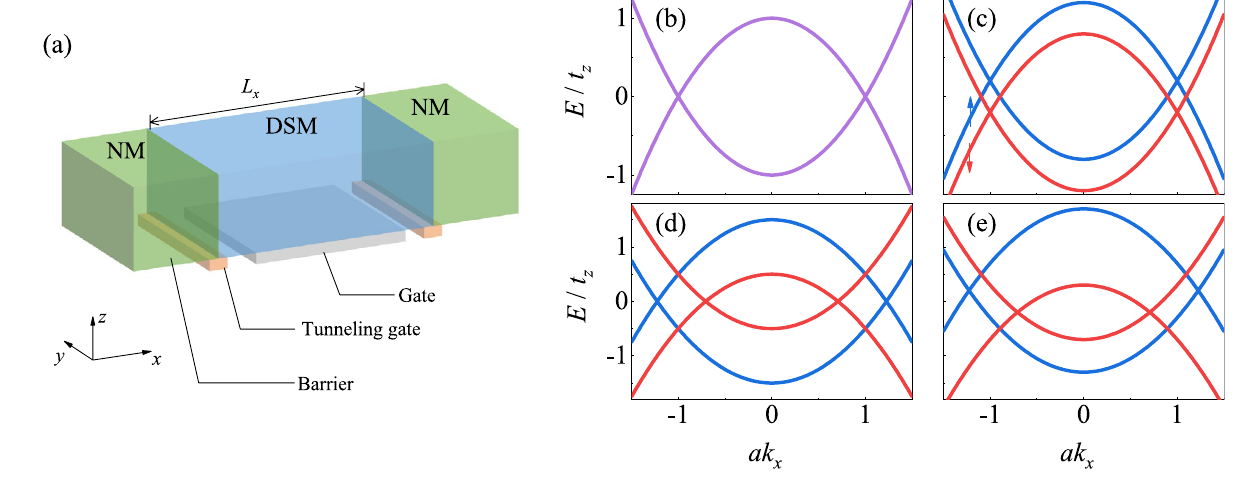
Figure 1. ( a ) Schematic for a normal metal (NM)/Dirac semimetal (DSM)/NM junction. The length of the junction is L x . The polarization of the current can be controlled by the barrier, gate and tunneling gate in the junction. ( b – e ) Dispersions of Dirac semimetals ( b ) without and ( c – e ) with Zeeman field. The spin-up and spin- down subband are plotted in blue and red, respectively. The Zeeman terms ( B � , B 0 ) are ( b ) (0, 0), ( c ) (0, 0.2), ( d ) (0.5, 0) and ( e ) (0.5, 0.2). The dispersions are calculated using the simplified parameters shown in Table 1.